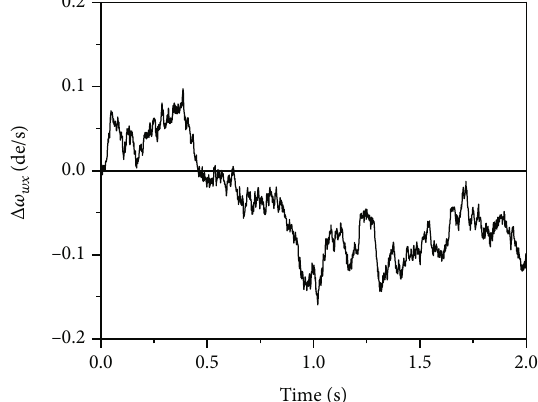
: 15 and k = 0 : 8 . ω = 0 n